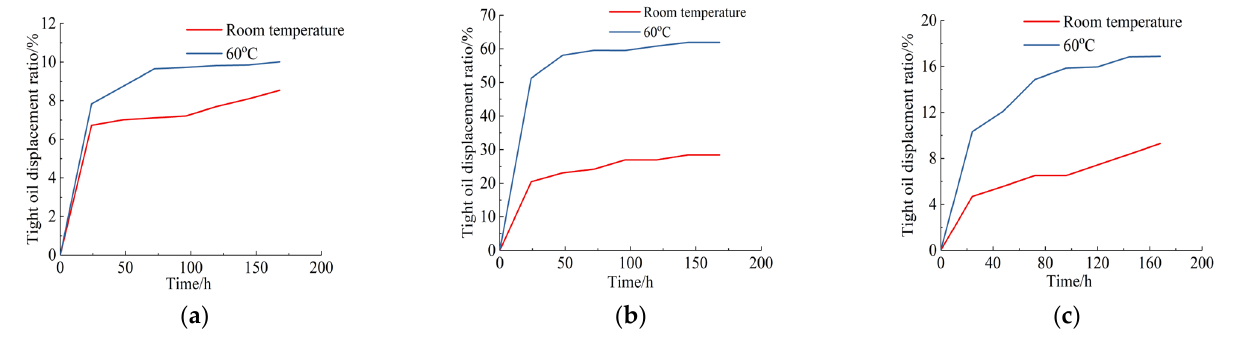
Figure 10. The relationship between temperature and tight oil displacement ratio. ( a ) Core